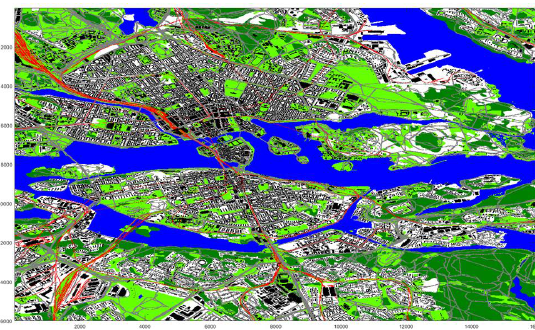
Figure 6. Labels provided by